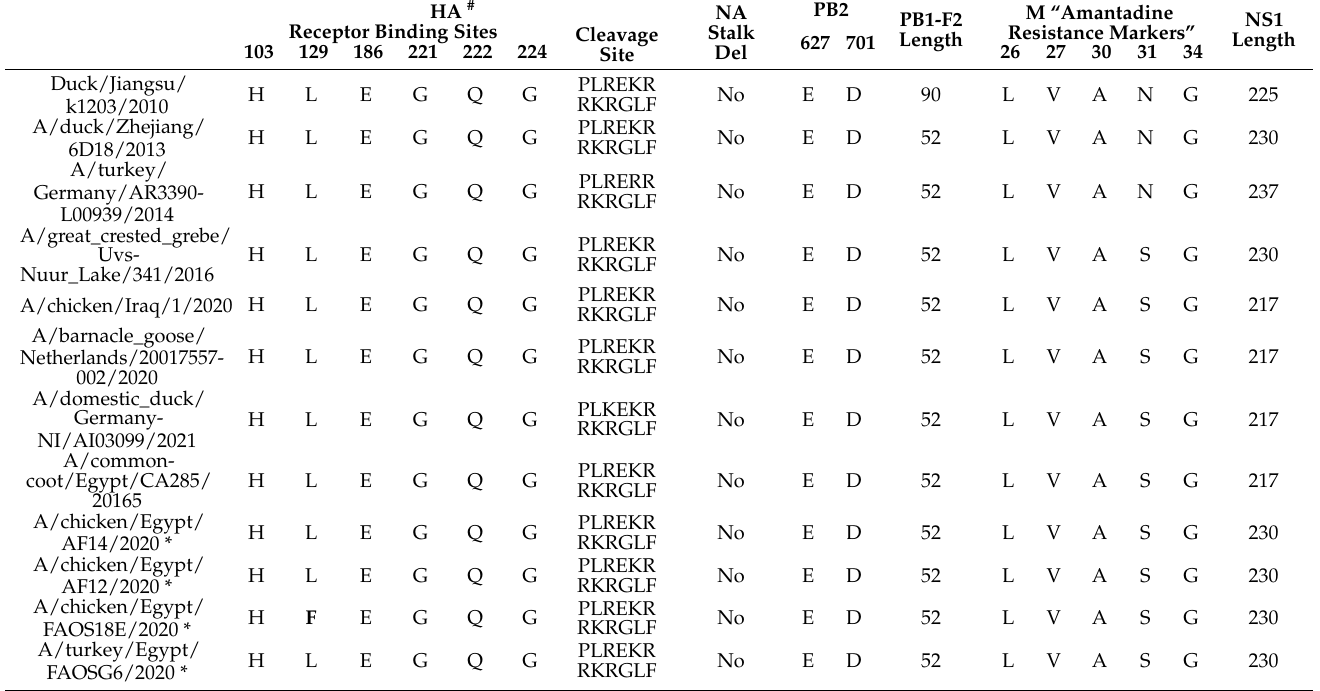
Table 1. Key amino acid analysis of the Egyptian HPAI H5N8 viruses among different proteins. HA # NA Stalk Del